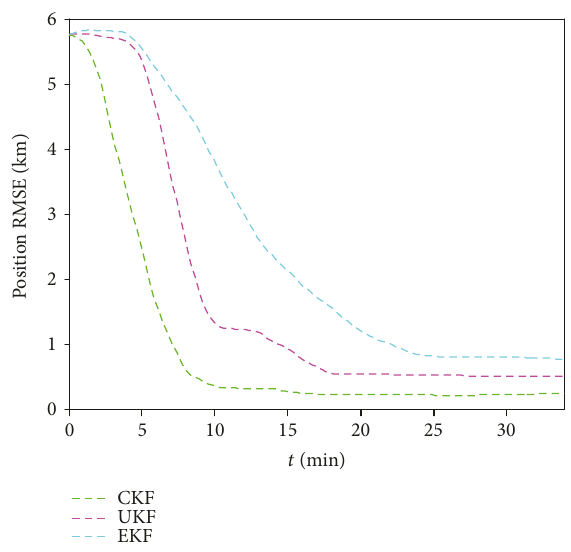
Figure 15: Comparison of position RMSE with EKF, UKF,